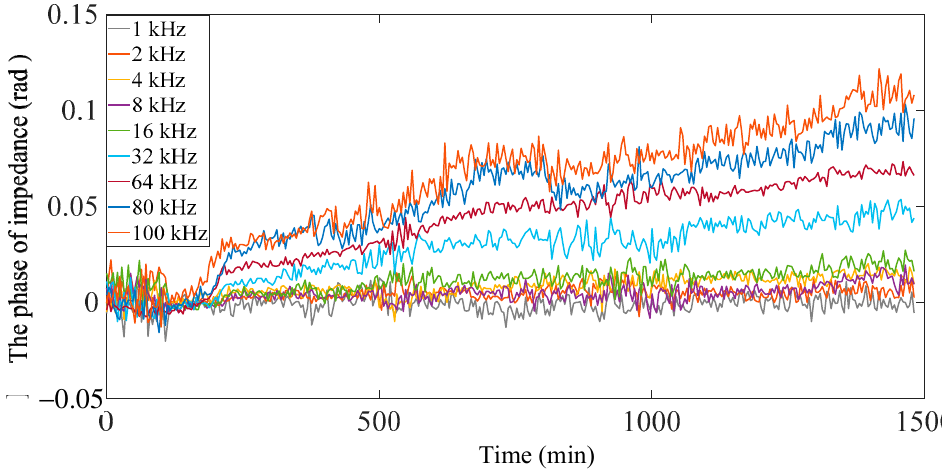
Figure 8. The magnitude curves of impedance of the Permalloy 1J85 current sensor.